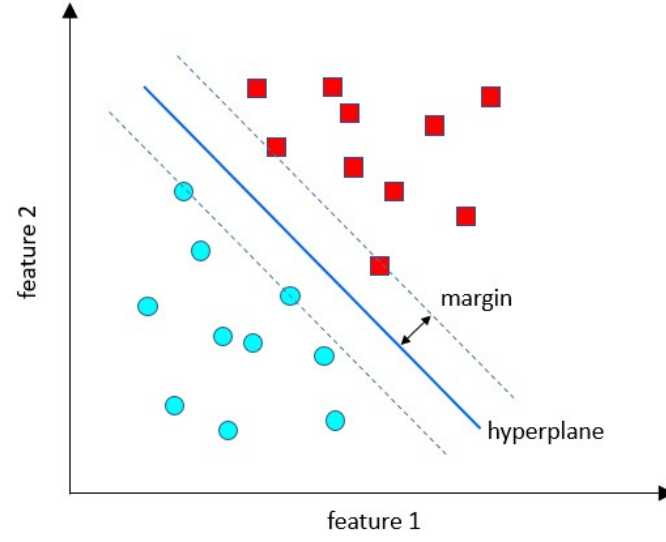
Figure 6. Concept of SVM.